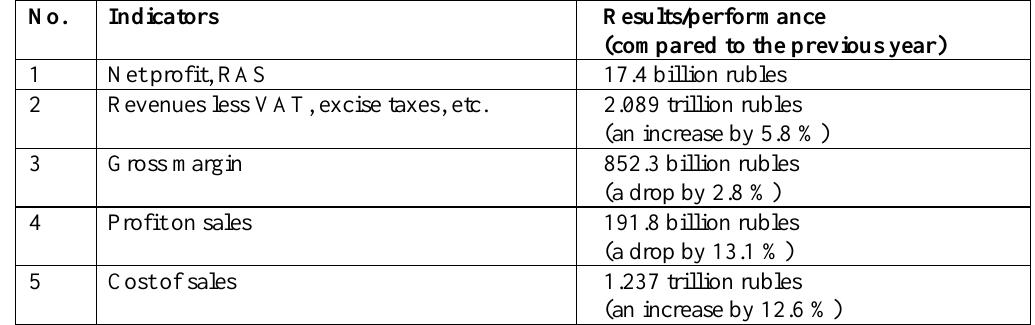
Table 1. Gazprom’s Performance of 1 July 2017 (Joint Stock Company Gazeta.ru,